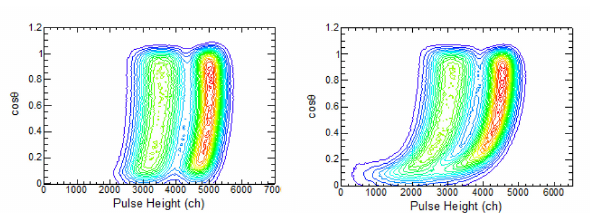
Fig. 6. Fission fragment pulse height versus the cosine of the fission axis relative to the axis of the incident neutron beam as obtained from the reaction 239 Pu(n,f). Left part: pulse height after having passed the target layer, right part: pulse height after passing the target layer and the polyimide